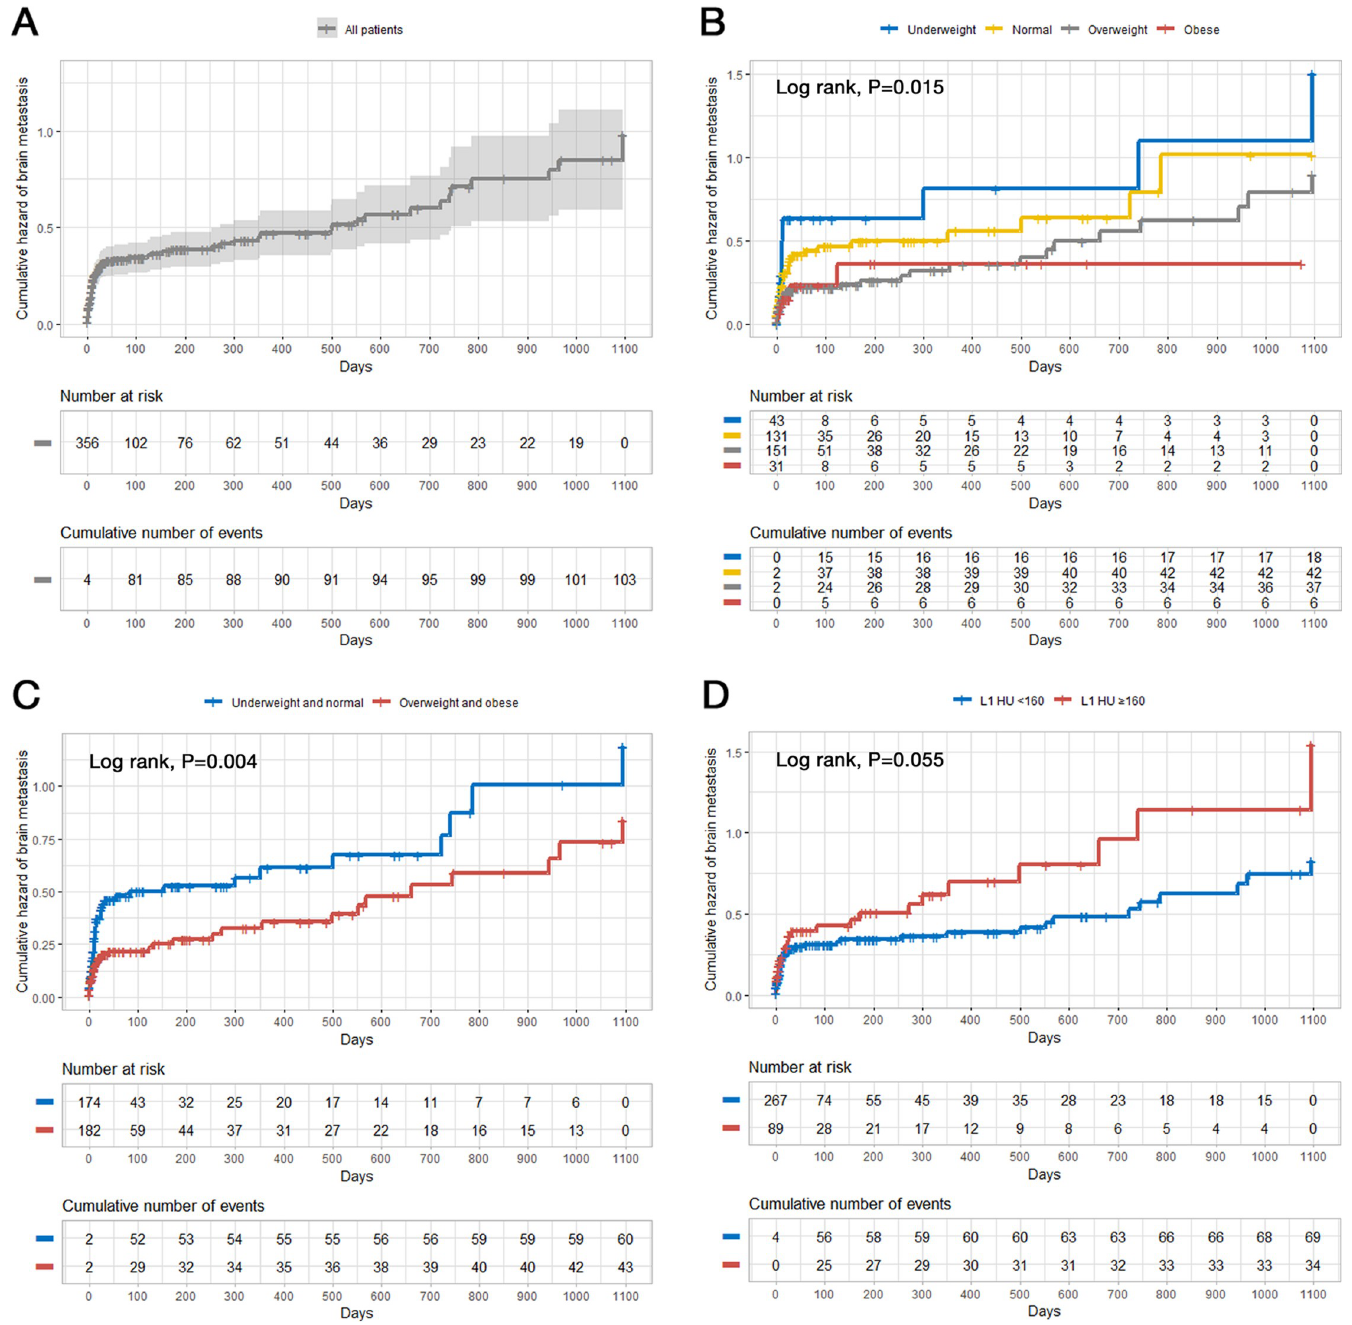
Fig 2. Cumulative hazard of brain metastasis according to the BMI and L1 HU classification. (A) overall; (B) four BMI categories (underweight, normal, overweight, and obese); (C) two BMI categories (underweight and normal, overweight and obese); (D) L1 HU classification (cut-off value of 160 HU). BMI = body mass index; HU = Hounsfield